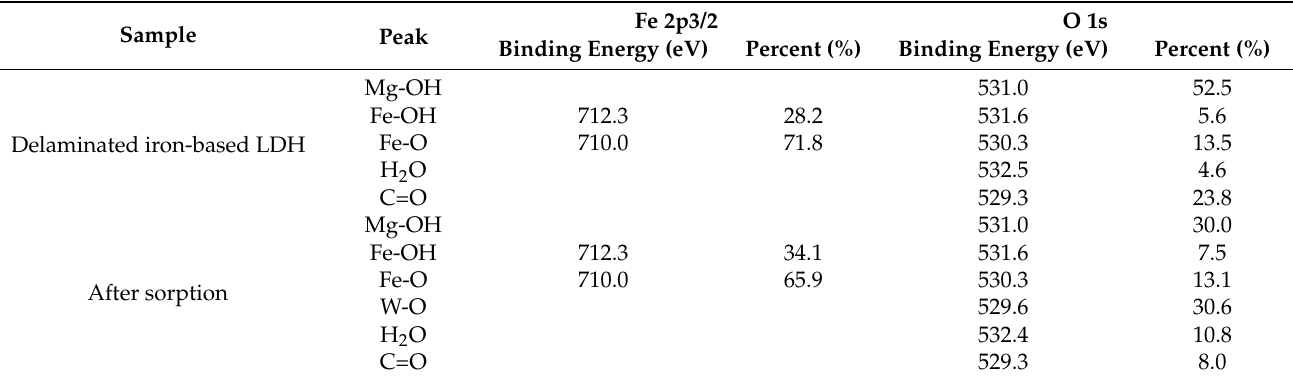
Table 4. Fitting parameters for Fe 2p3/2 and O 1s XPS